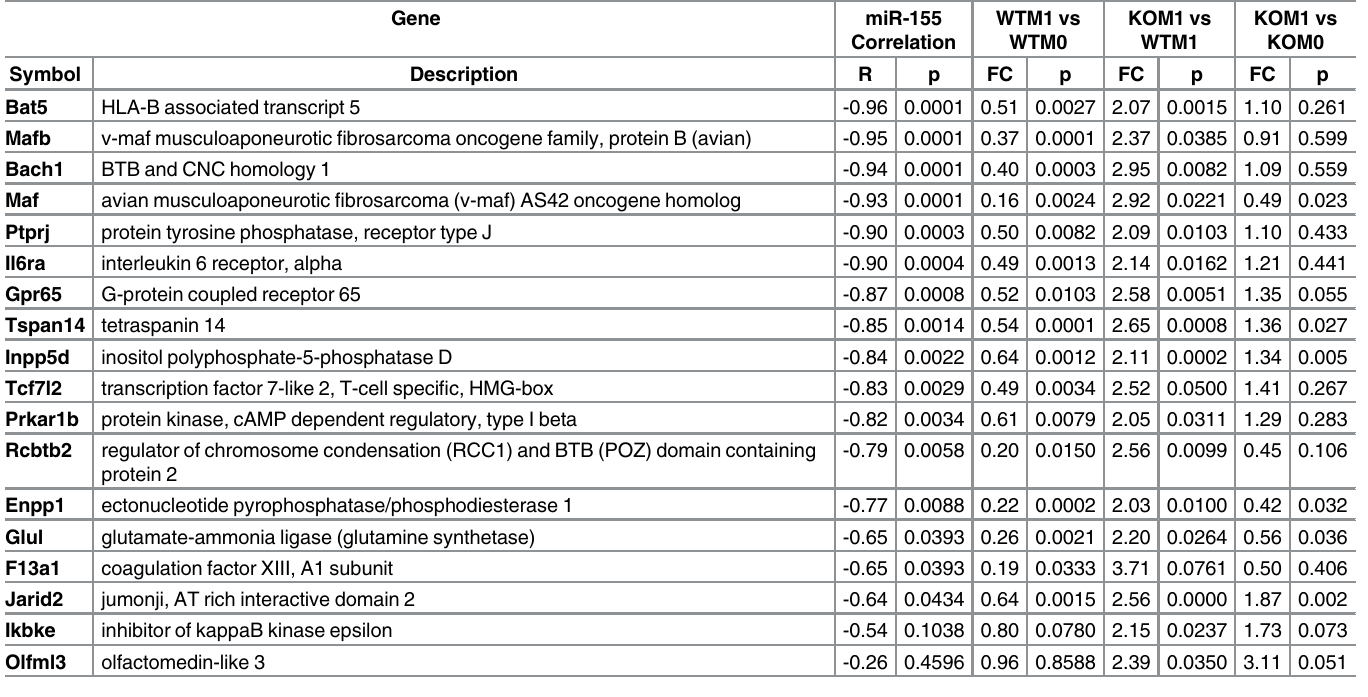
Table 1. miR-155 targets up-regulated more than 2 fold-change in KOM1(LPS + IFN- γ ) vs. WTM1(LPS + IFN- γ )